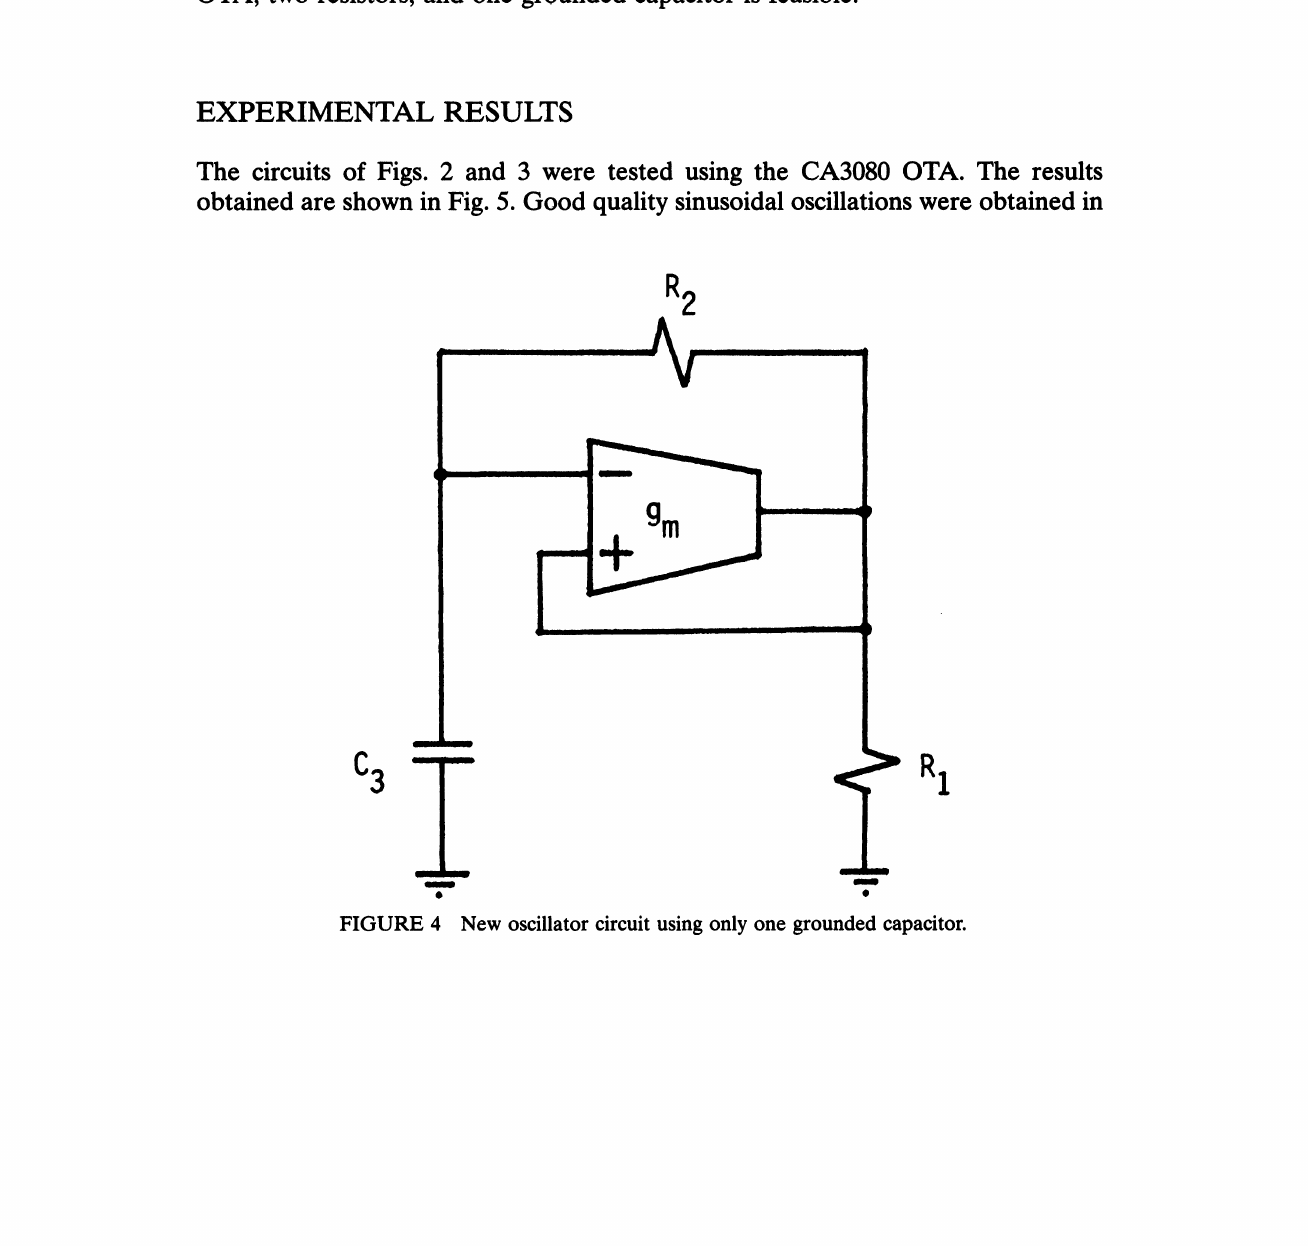
FIGURE 4 New oscillator circuit using only one grounded